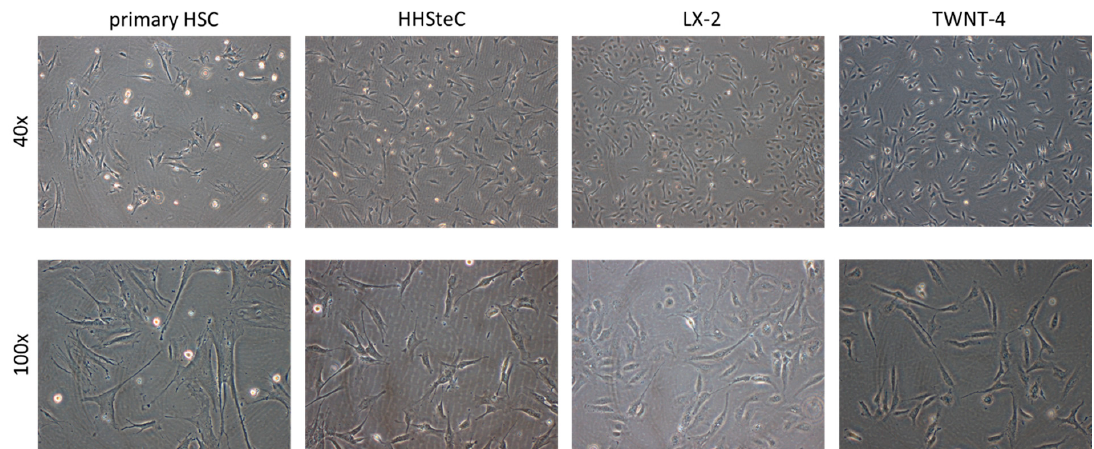
Figure 1. Morphology of various human stellate cell cultures (primary hepatic stellate cell (HSC), HHSteC, LX ‐ 2 and TWNT ‐ 4 cells). Representative light microscopy images were captured at 40× and 100× magnification at 1 day after seeding.